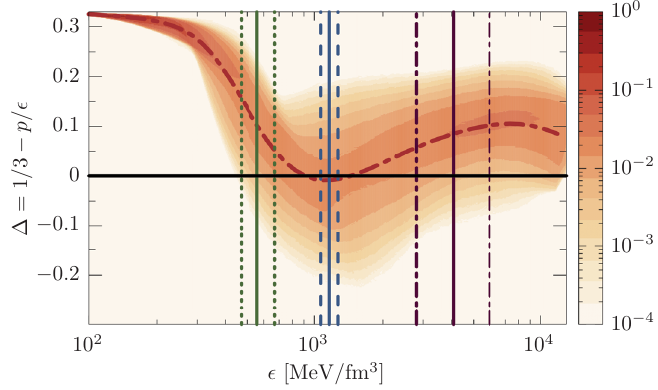
Figure 2. The same as in Fig. 1 but for trace anomaly. Horizontal, black line marks the conformal value of Δ =